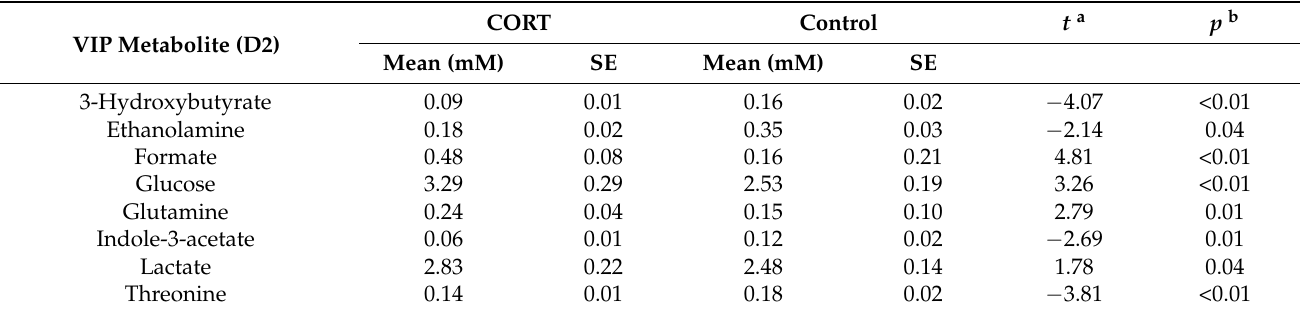
Table 2. Mean and standard error mean (SE) for concentrations (mM) for serum polar metabolites of lesser scaup ( Aythya affinis ) that were identified to have variable importance in projection (VIP) score > 1, using PLS-DA modeling for D2.